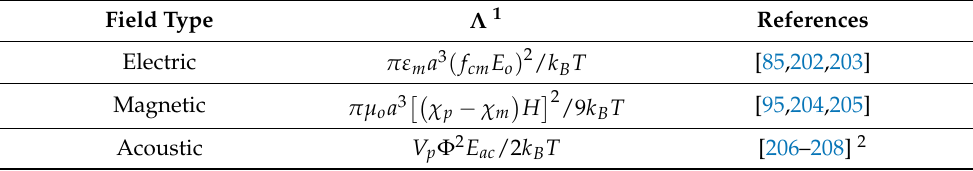
Figure 7. Elastic moduli for a composite of magnetically aligned particles with the load applied: ( A ) In the direction of alignment; ( B ) in the transverse direction of alignment. Reprinted with permission from [35], copyright 2006 Elsevier. ( C ) Stress-strain curves for a 3D printed fiber without particles (squares), with randomly distributed particles (circles), and acoustically assembled particles (triangles). Reprinted with permission from [198], copyright 2020 Royal Society of Chemistry. Table 1. Dimensionless energy density for the mechanisms examined in this review.